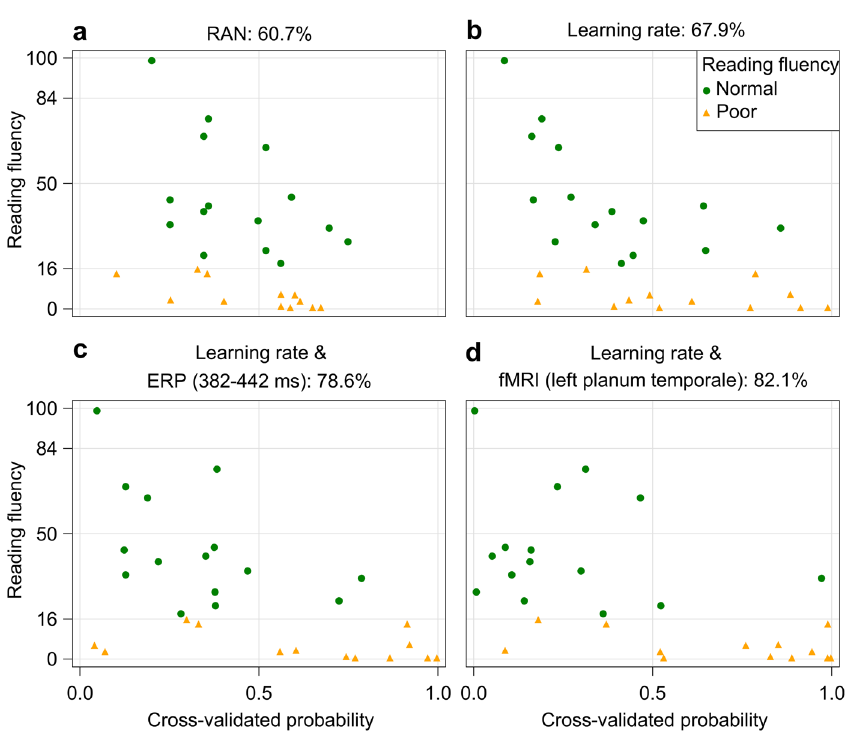
Figure 2. Prediction accuracy of multiple logistic regression models. Each subject’s cross-validated probability of being classified as a poor reader is plotted against each subject’s mean reading fluency ( n = 28). Factors included in each multiple logistic regression model and overall cross-validated prediction accuracy are superimposed to each